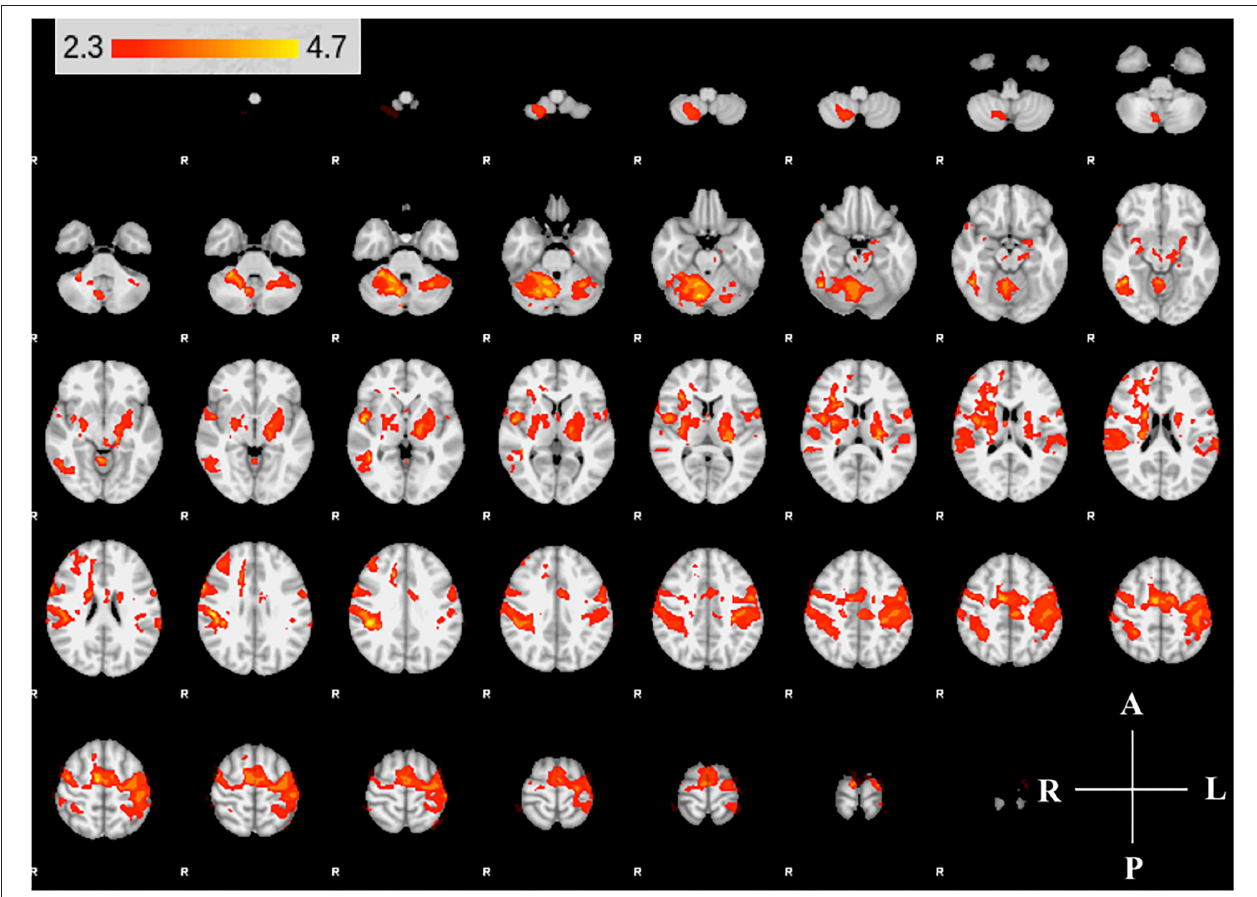
FIGURE 4 | Group activity maps of control participants. The figure shows slices of the MNI template overlaid with z-statistic ( Z > 2.3) maps of W0 and W6 average control group activity during non-dominant hand movement. Activity maps indicate volumes in which there was significant ( p < 0.05) levels of activity across the group. The right hemisphere of the brain is displayed on the left. Right hemisphere is ipsilateral to the movement arm. No differences were detected between W0 and W6.